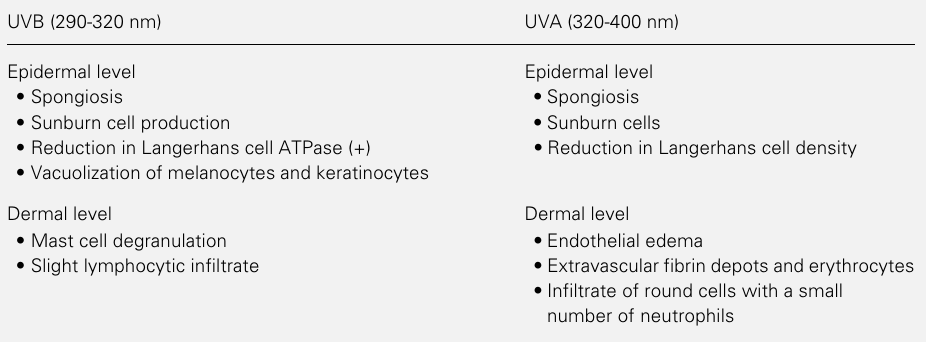
Table 3 - Major histological features of ultraviolet radiation-induced erythema. UVB (290-320